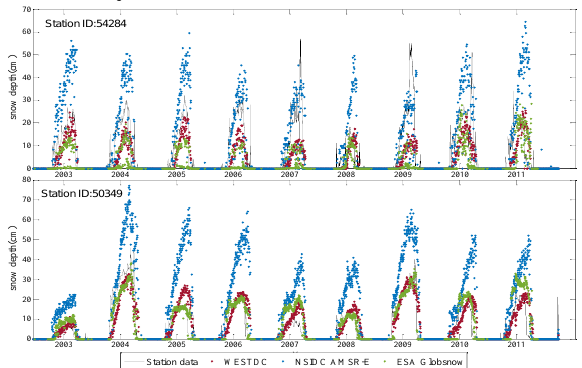
Figure 3. The snow depth are compared to in situ observation from 2002 to 2011